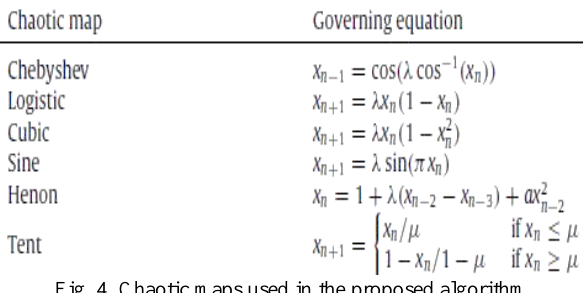
Fig. 4. Chaotic maps used in the proposed algorithm In this step, the image bands are separated and placed together and a matrix is formed. By using the XOR key, the encryption block is formed and the input image matrix is combined to change the DN values of the image. Combination between mapping Chaos is shown as figure 5.